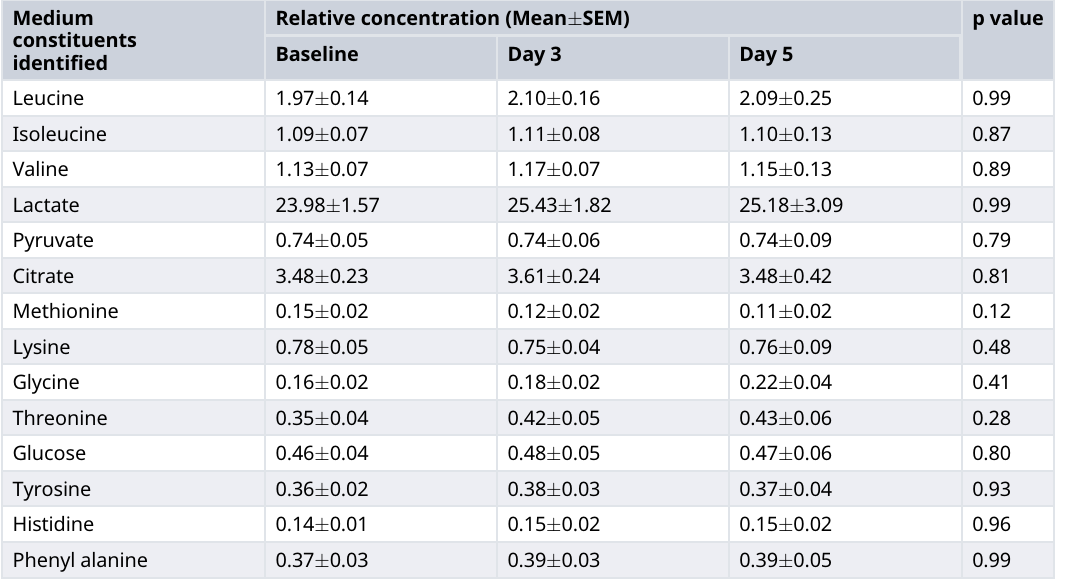
Table 2. Sham incubation of V-ONESTEP medium at 20% O 2 , subjected to nuclear magnetic resonance (NMR) analysis showing the relative concentration of medium constituents (normalized to TSP) at various time points. SEM=standard error of mean, TSP = Sodium salt of 2,2,3,3 tetradeutero 3-(trimethyl silyl)